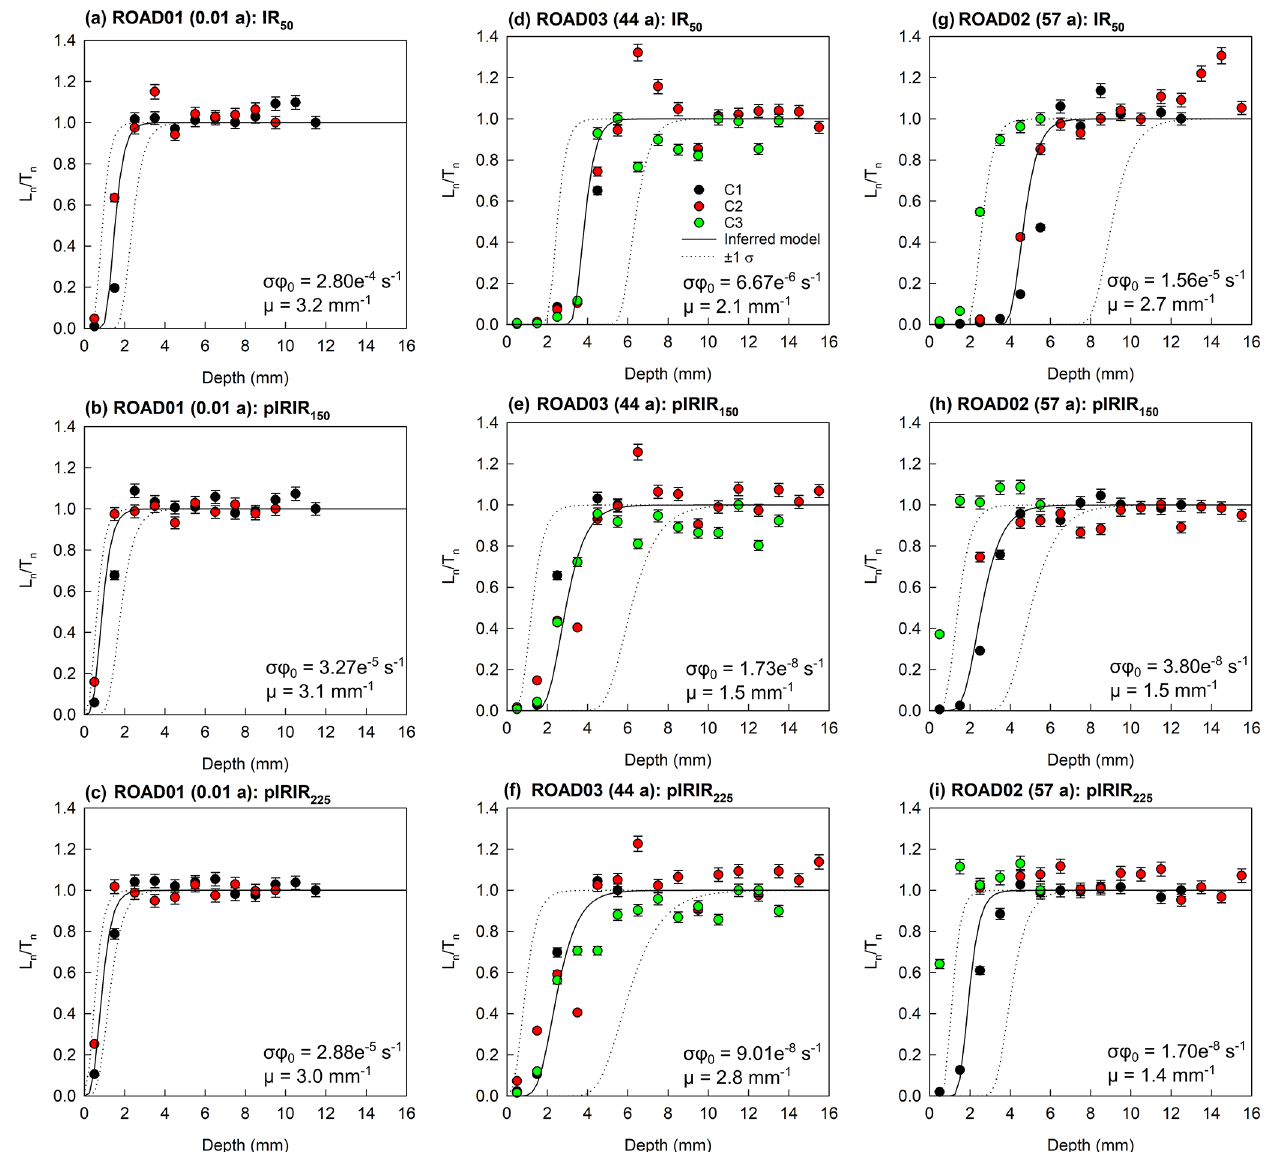
Figure 4. Presented in age order are the IRSL depth profiles for each of the three replicate cores analysed per sample using the IR 50 (a, d, g) , pIRIR 150 (b, e, h) and pIRIR 225 (c, f, i) signals for samples ROAD01 (0.01a; a–c ), ROAD03 (44a; d–f ) and ROAD02 (57a; g–i ). All of the raw L n /T n data presented in this figure (Tables S2–S4) were normalised individually for each core, and subsequent analysis uses the data in this format. The black line shown is the best fit of the inferred model that was fitted to derive the corresponding σϕ 0 and µ values included in each panel. The dotted lines show the corresponding fits modelled using the ± 1 σσϕ 0 and µ values (Table 2). Note that core 3 of ROAD02 was not considered for